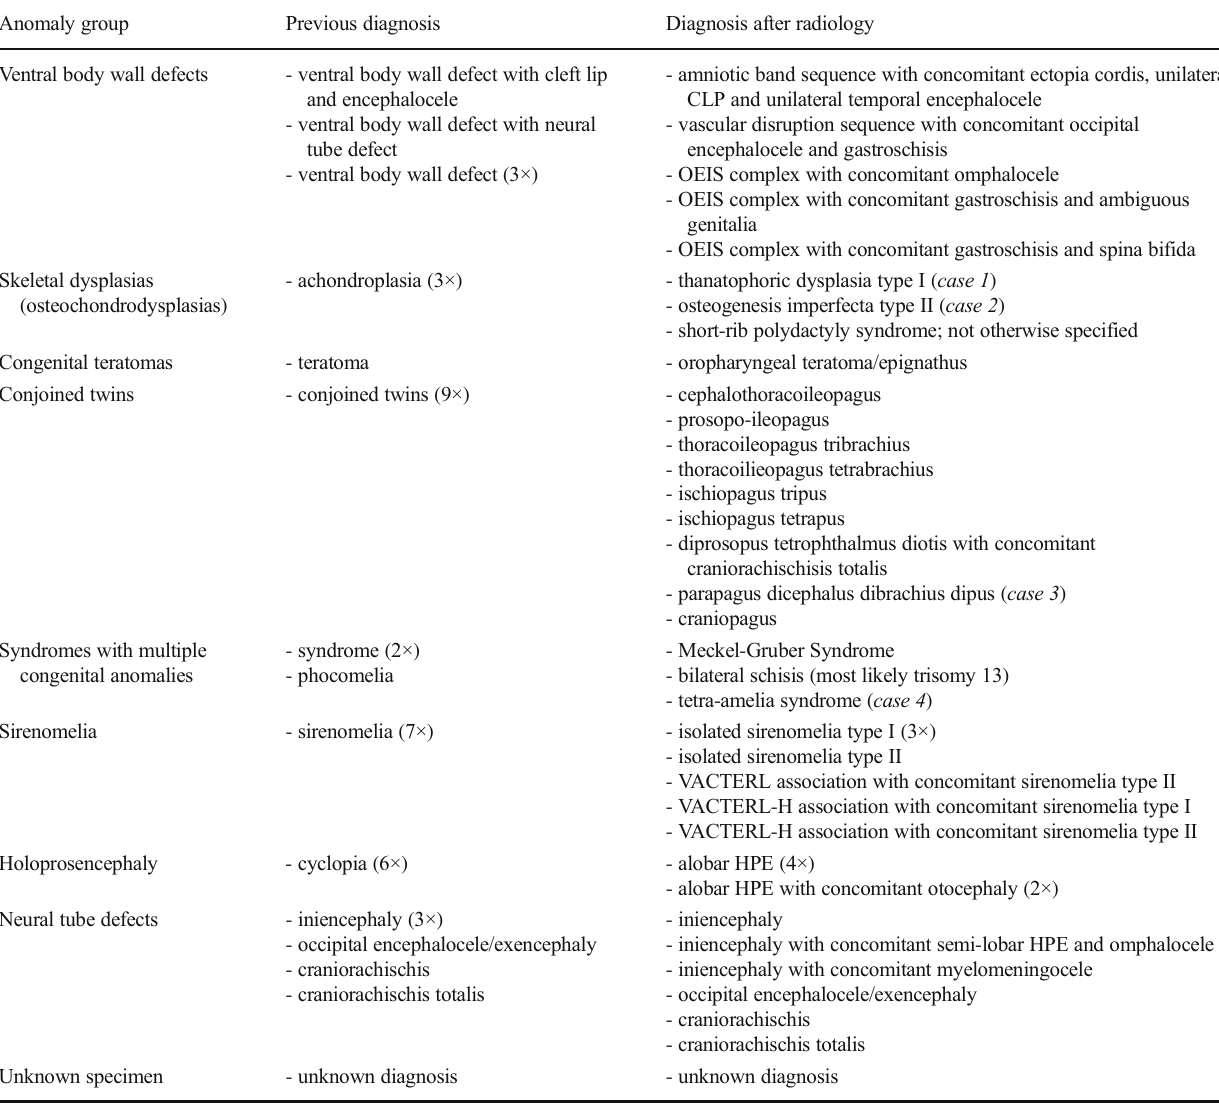
Diagnostic revision in 41 scanned teratological